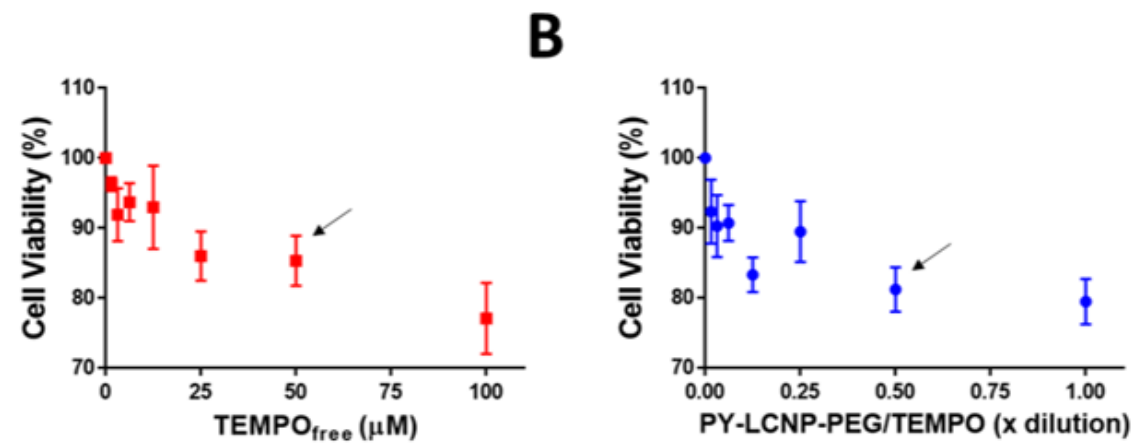
Figure 6. Quantification of cell viability. Indicated concentrations of TEMPO free ( A ) and serially diluted PY-LCNP-PEG/TEMPO ( B ) were used to measure cell variability using MTS assay. The 0.50× diluted PY-LCNP-PEG/TEMPO corresponds to a ~27 nM particle concentration containing 50 µM of conjugated TEMPO. Cells were incubated with TEMPO free or PY-LCNP-PEG/TEMPO, washed, and cultured in growth medium for 72 h prior to the MTS assay. Average ( n = 4 ± SEM) cell viability for different concentrations of TEMPO free and PY-LCNP-PEG/TEMPO plotted as a percentage of control cells (not treated). Cell viability (>80%) of the comparable concentration (~50 µM) of TEMPO in a free or conjugated form are indicated by the arrows.